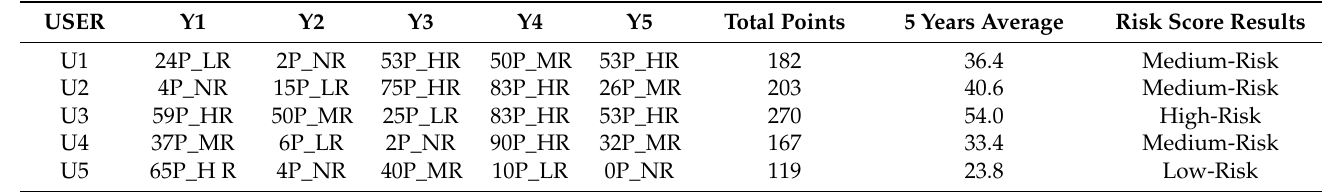
Table 7. Driver risk score average over 5